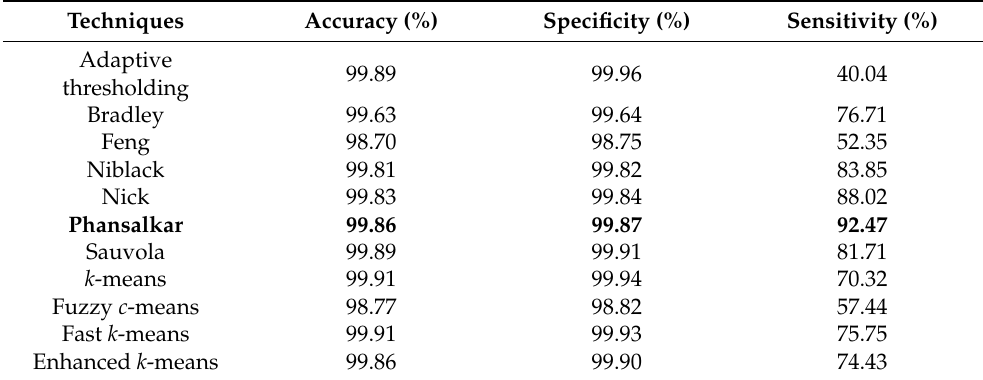
Table 4. Average segmentation evaluation consisting of accuracy, specificity, and sensitivity of 200 thick blood smear